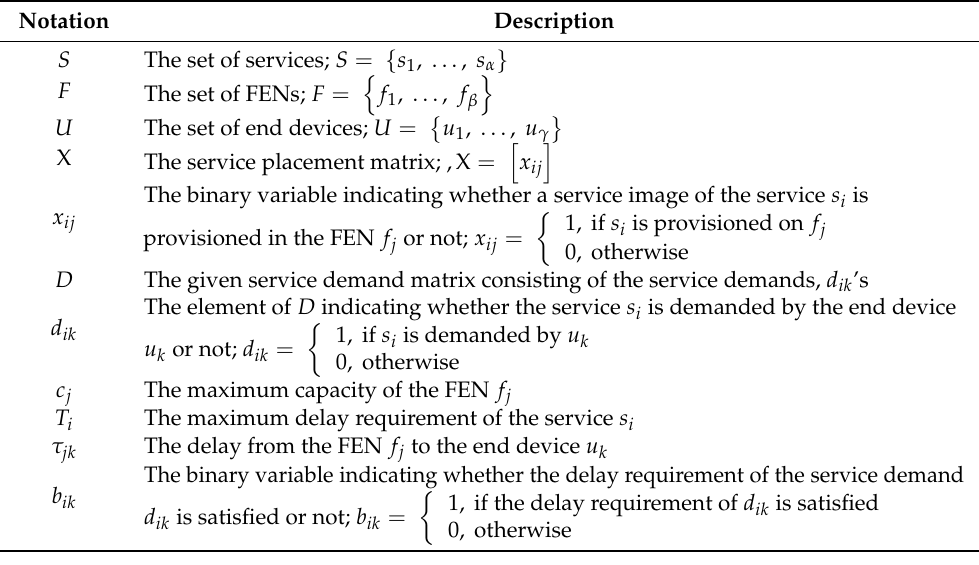
Table 1. Notations for the definition of the optimal service provisioning (SP)